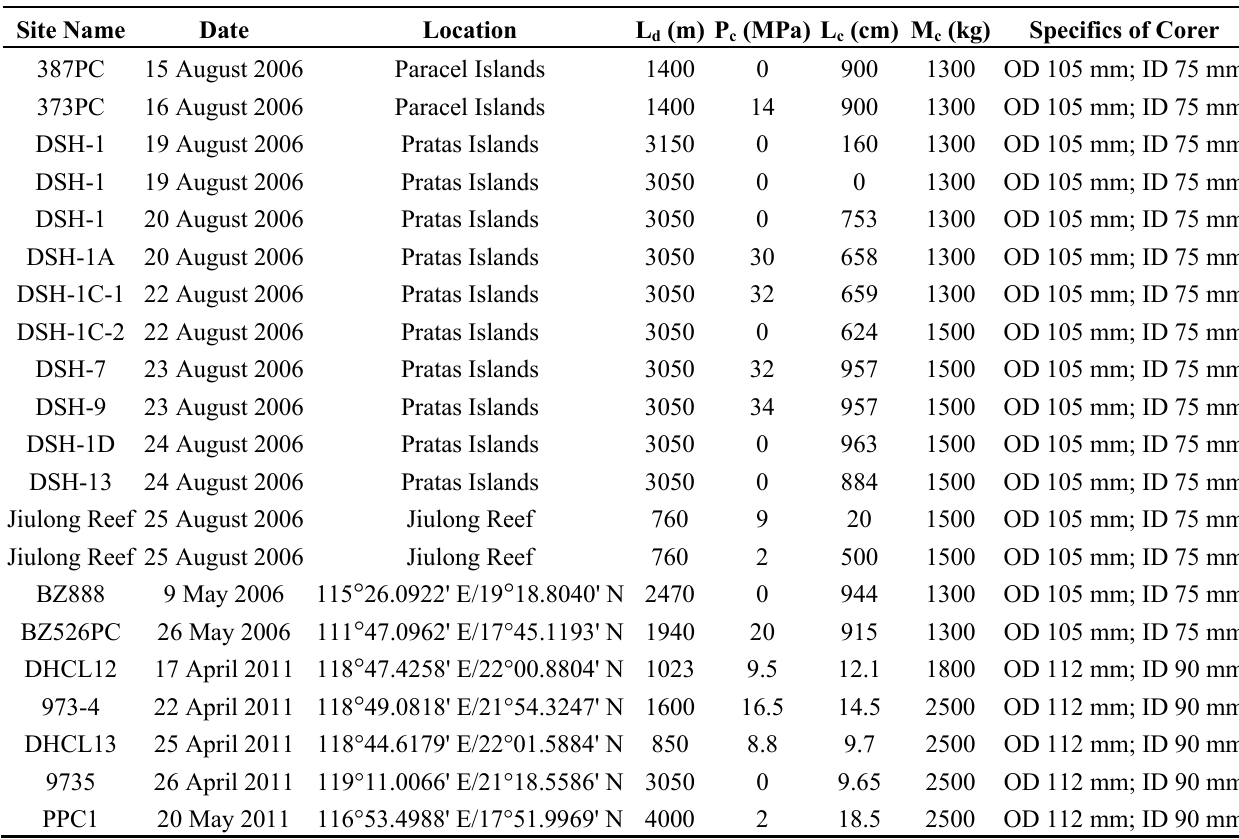
Table 2. Sea trial results for a long pressure-retained corer.